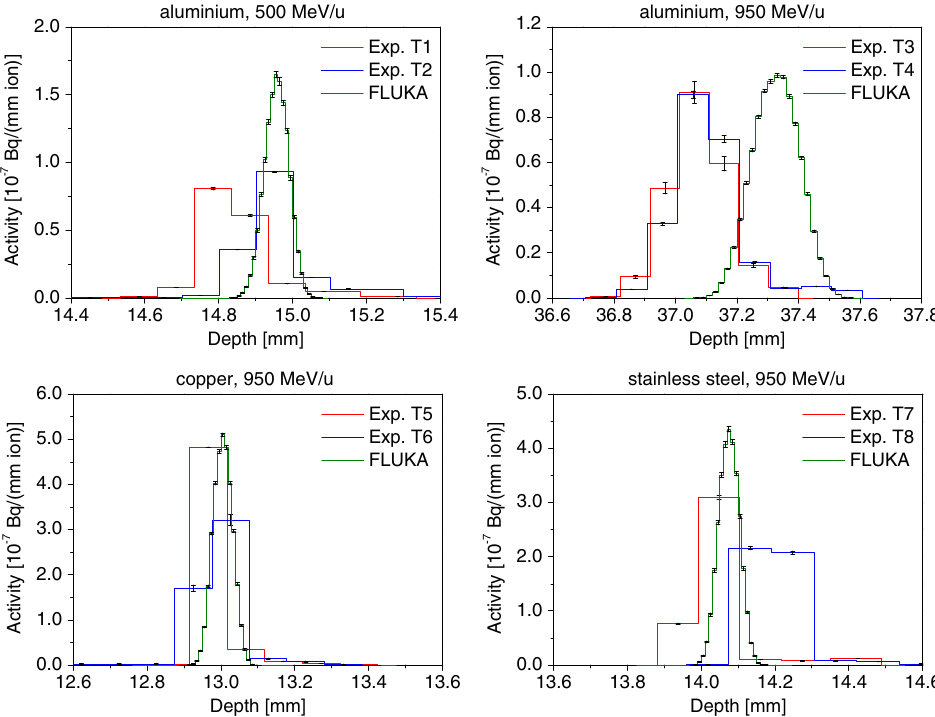
FIG. 5. Depth profiles of the 237 U residual activity measured experimentally and simulated by FLUKA2011.2.3 in aluminum, copper, and stainless-steel targets irradiated with 238 U primary ions with the initial energy 500 and 950 MeV = u